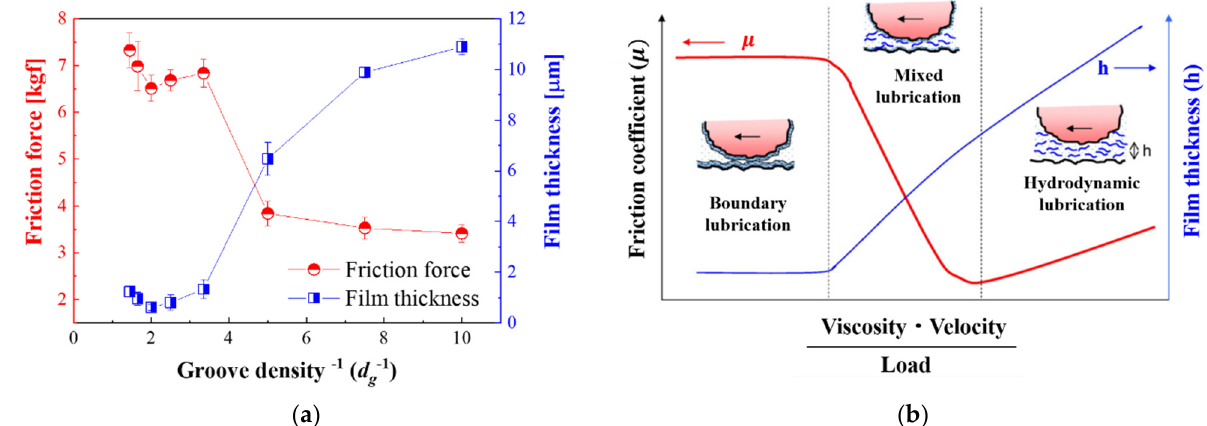
Figure 11. ( a ) Film thickness and frictional force as a function of the inverse number of groove density; ( b ) friction coefficient plotted as a function of fluid viscosity and shear velocity divided by load (Stribeck curve) with corresponding lubrication film thickness [27].